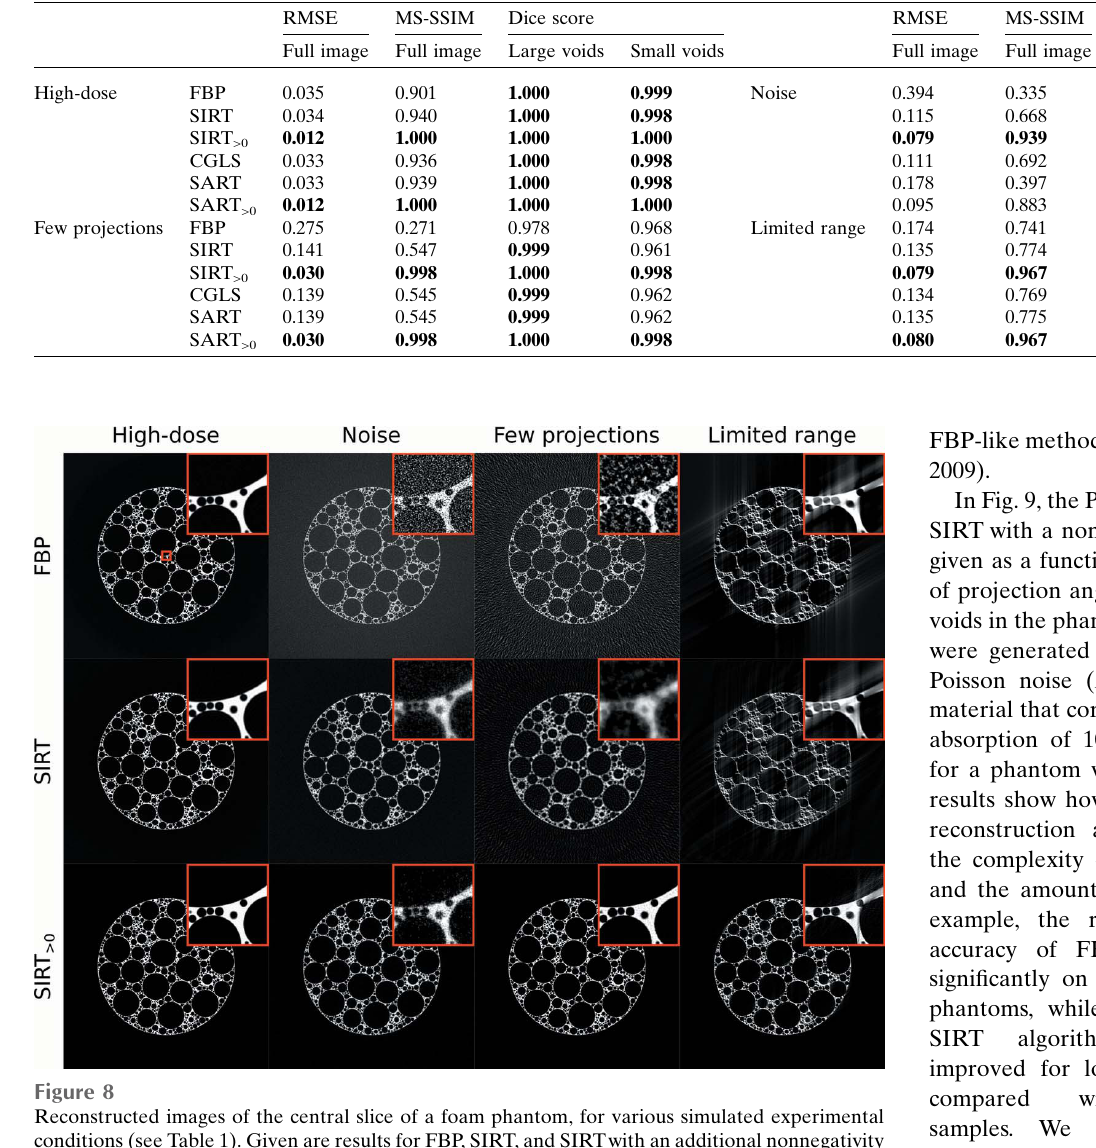
Table 2 Reconstruction results for various simulated experimental conditions (see Table 1). Additional nonnegativity constraints are indicated by ‘ >0 ’. Metrics within 2% of the best metric in each column are shown in bold .